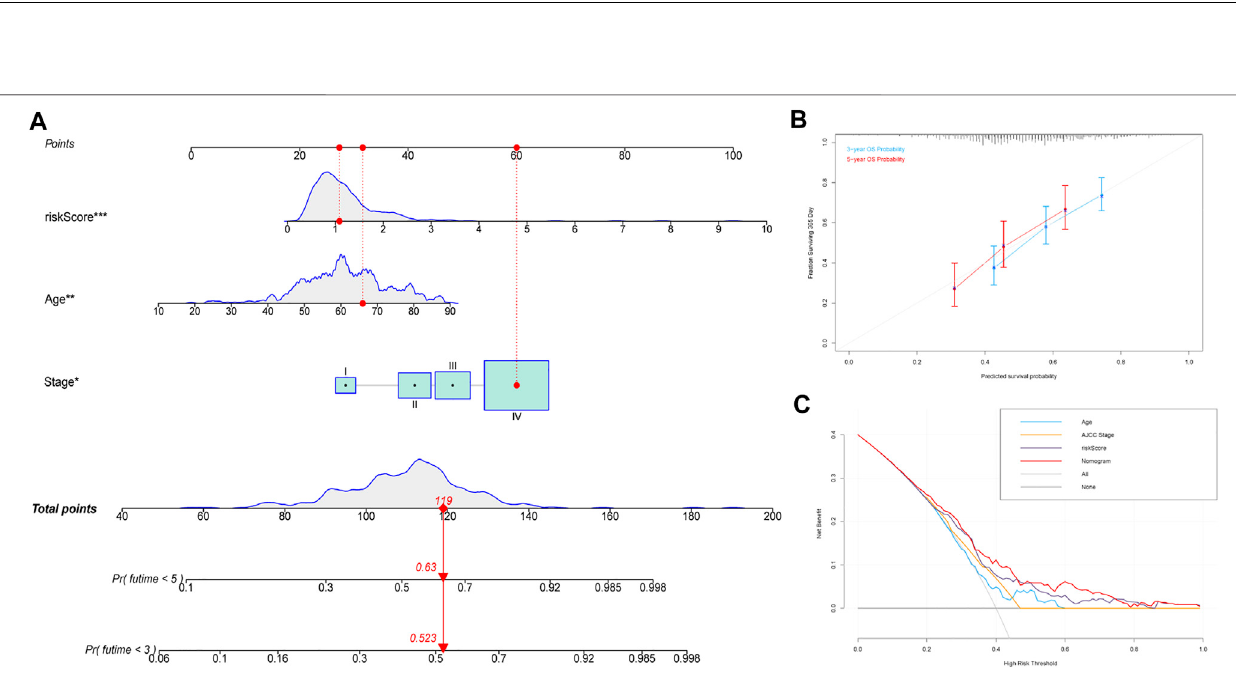
FIGURE 6 | Independent prognostic factors for the OS in patients with HNSCC. Univariate and multivariate Cox regression analyses were performed using TCGA dataset (A,B) and GEO dataset (C,D) . Abbreviations: GEO, Gene Expression Omnibus; HNSCC, head and neck squamous cell carcinoma; OS, overall survival; TCGA, The Cancer Genome Atlas.